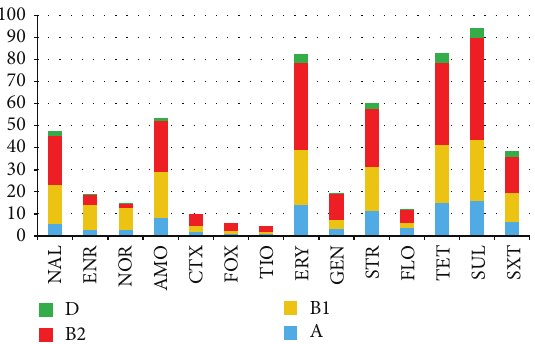
Figure 1: Distribution of 225 APEC strains in relation to antibi- otic resistance. NAL: nalidixic acid, ENR: enrofloxacin, NOR: norfloxacin, AMO: amoxicillin, CTX: cefotaxime, FOX: cefoxitin, TIO: ceftiofur, ERY: eritromicin, GEN: gentamycin, STR: strep- tomycin, FLO: florfenicol, TET: tetracycline, SXT: sulfamethoxa-